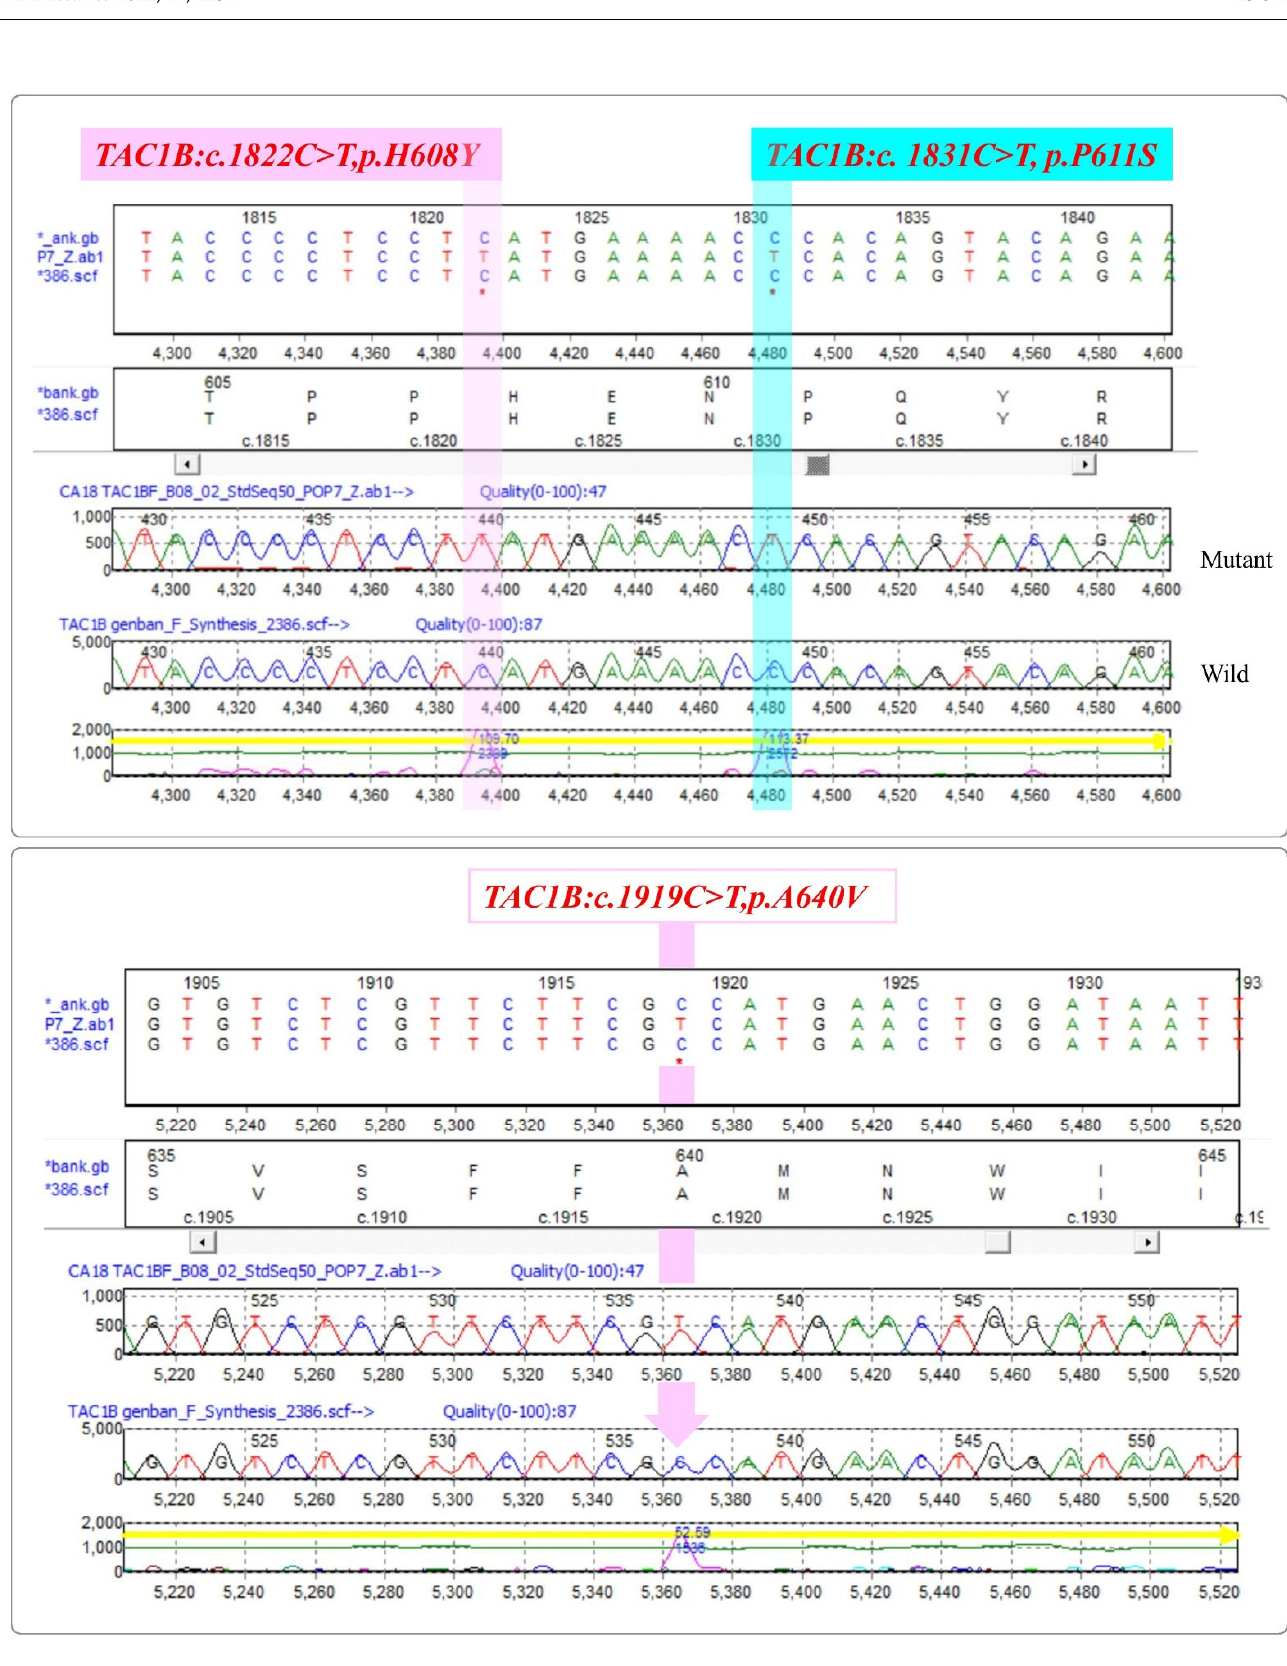
Figure 4. List of missense variants identified in the zinc-cluster transcription factor-encoding gene ( TAC1B ) of Candida auris isolates. Top left: TAC1B:c.1822C > T,p.H608Y . Top right: TAC1B:c. 1831C > T, p.P611S . Bottom: TAC1B:c.1919C > T,p.A640V . Reference sequence: GenBank Accession: MW368409.1. * indicates change of nucleotide at this position.